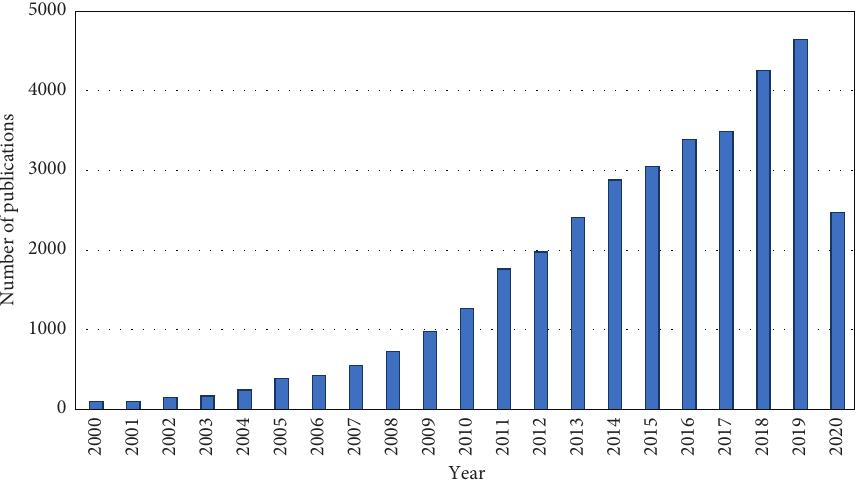
Figure 3: Number of papers published on AgNPs (according to the Web of Science database; between January 2000 and May 2020). Table 1: Magnetic adsorbents used for the separation and preconcentration of Ag ions and AgNPs. Analyte